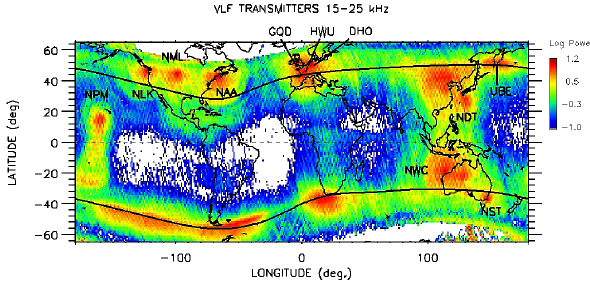
Fig. 7. Top panel: position of the three Russian transmitters emit- ting in the Northern Hemisphere at 11.8, 12.8 and 14.8kHz. Mid- dle panel: consecutive frequency band ratio for the Northern Hemi- sphere. Bottom panel: same for the Southern Hemisphere. conjugate structure in the Southern Hemisphere, after flying over the dayside (nightside) part of the Earth. Single traces correspond to structures with no conjugate. The structures are thus well organized in a UT–longitude space, indicating a probably geographic origin. The bottom panel of Fig. 9 gives the latitude–longitude distribution, with superposed curves giving the L = 2 and L = 1 . 5 locations in the Northern and Southern hemispheres. The structures are mainly grouped along L = 2, with two notable exceptions: in the US sector at longitudes from − 100 to − 70 ◦ and in the South African sec- tor at longitudes between 10 and 40 ◦ , where they are located at lower L